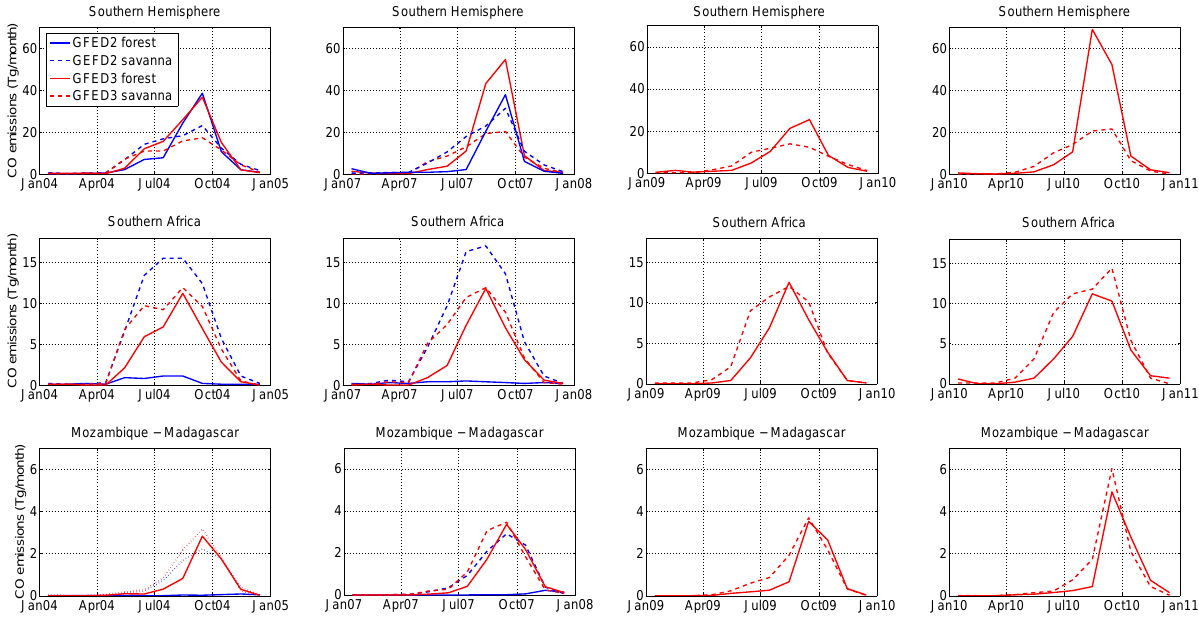
Fig. 5. CO emissions (Tgmonth − 1 ) from the GFED2 (in blue) and GFED3 (in red) inventories, for the southern Hemisphere (top panel), Southern Africa (middle panel), and the region of Mozambique and Madascar (bottom panel). The contribution from forests (solid lines) and savannas (dashed lines) are